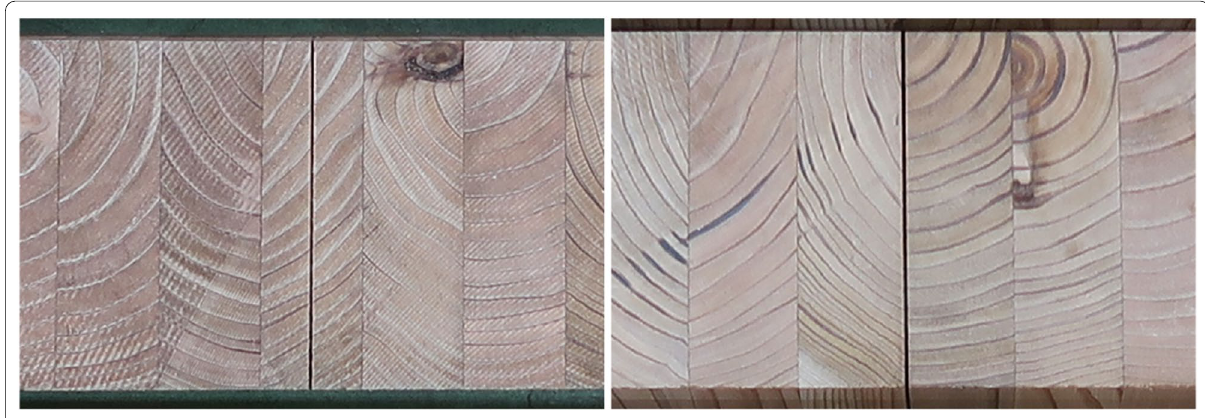
Fig. 7 Lower surface of the representative